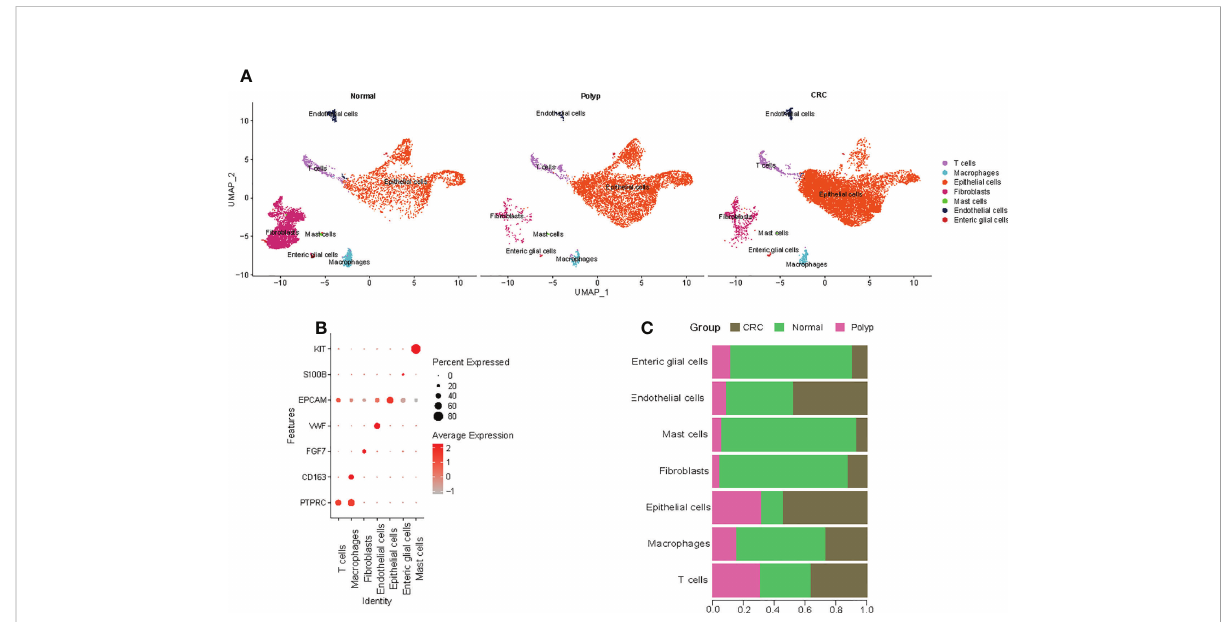
FIGURE 1 Cell types in the colon tissue from normal individuals, patients with polyps, and adenomas. (A) The UMAP plots of cell types from six samples. (B) Dot plot of the proportion of cells in the respective cluster expressing selected marker genes. (C) The bar plot shows the fraction of cells originating from the different